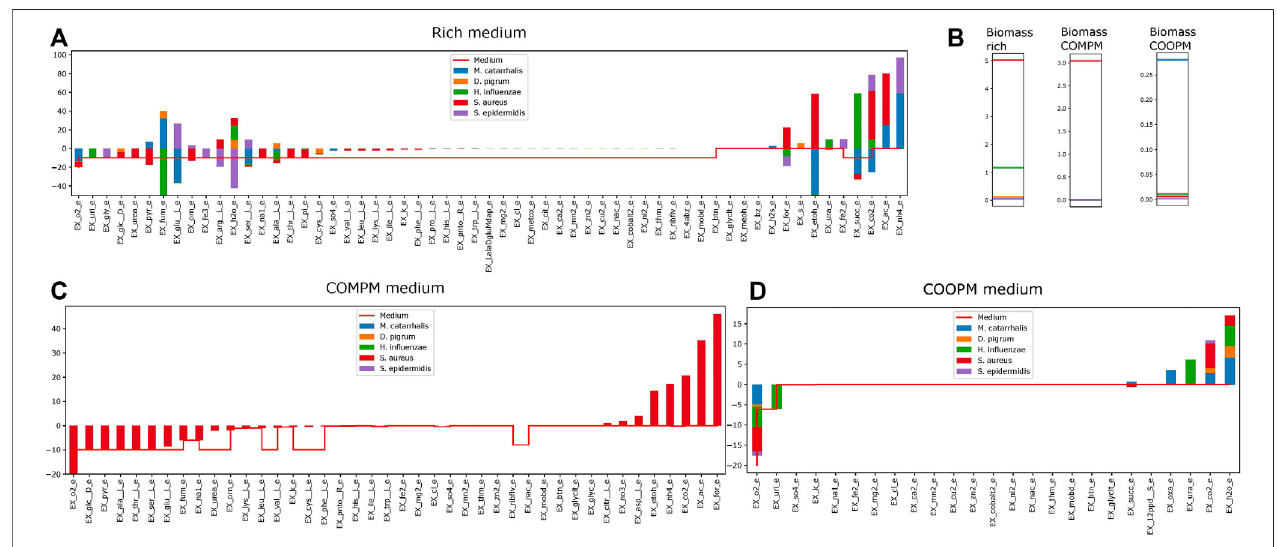
FIGURE7| HowmuchconcentrationofeachmetabolitesareconsumedorproducedbyeachmodelwhentheyareinthecommunityforrichSNM3[panel (A) ],the COMPM [panel (C) ], and the COOPM [panel (D) ]. In panel (B) , we show the individual biomass rates